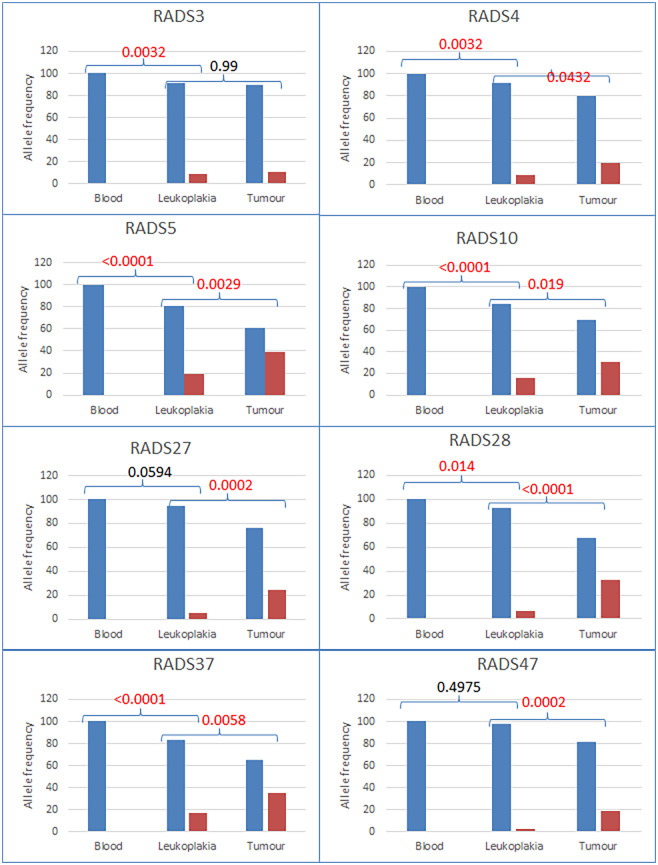
Wild type and mutated allele frequencies of CASP8 in blood, leukoplakia and tumor tissues of the patients.Wild type (blue bars) in blood DNA and mutated allele (red bars) frequencies in adjacent (located within 2–5 cm of tumor sites) leukoplakia and cancer tissues were plotted. Both leukoplakia and cancer tissues had identical type of mutation. For each of the plotted samples, mutated allele was found to be absent in blood DNA but present in leukoplakia and tumor tissues. Its frequency increased in cancer compared to adjacent leukoplakia tissue (p <0.05 for seven samples while p>0.05 in one sample).